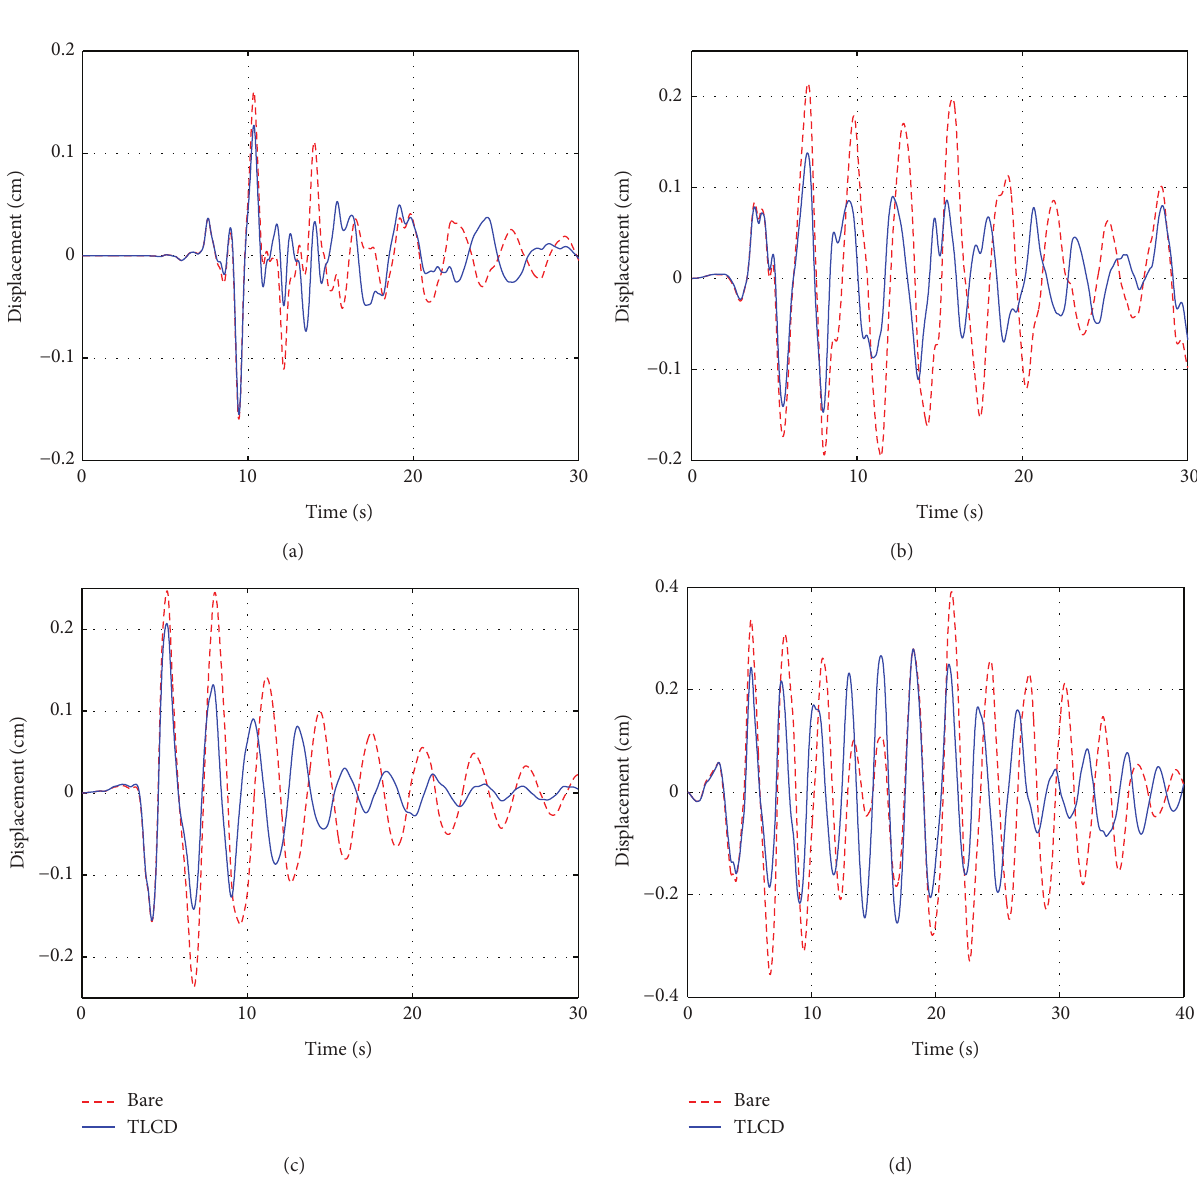
Figure 7: Time history comparison for the top floor displacement: (a) under Kobe wave; (b) under El Centro wave; (c) under North wave; (d) under Hach